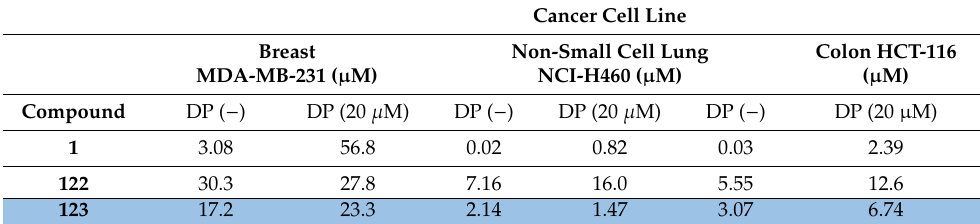
Table 5. GI 50 values of 1 , 122 and 123 in the presence or absence of